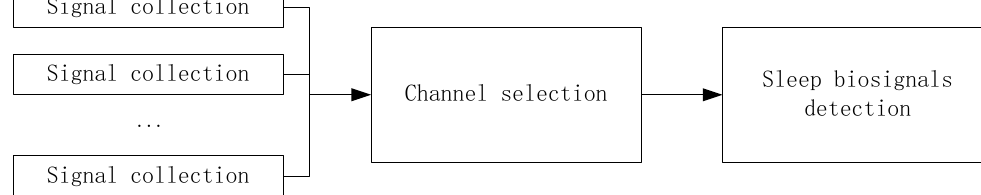
Figure 1. The framework of the sleep biosignals detection system.